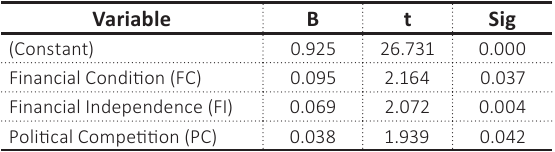
Table 4. Multiple regression test